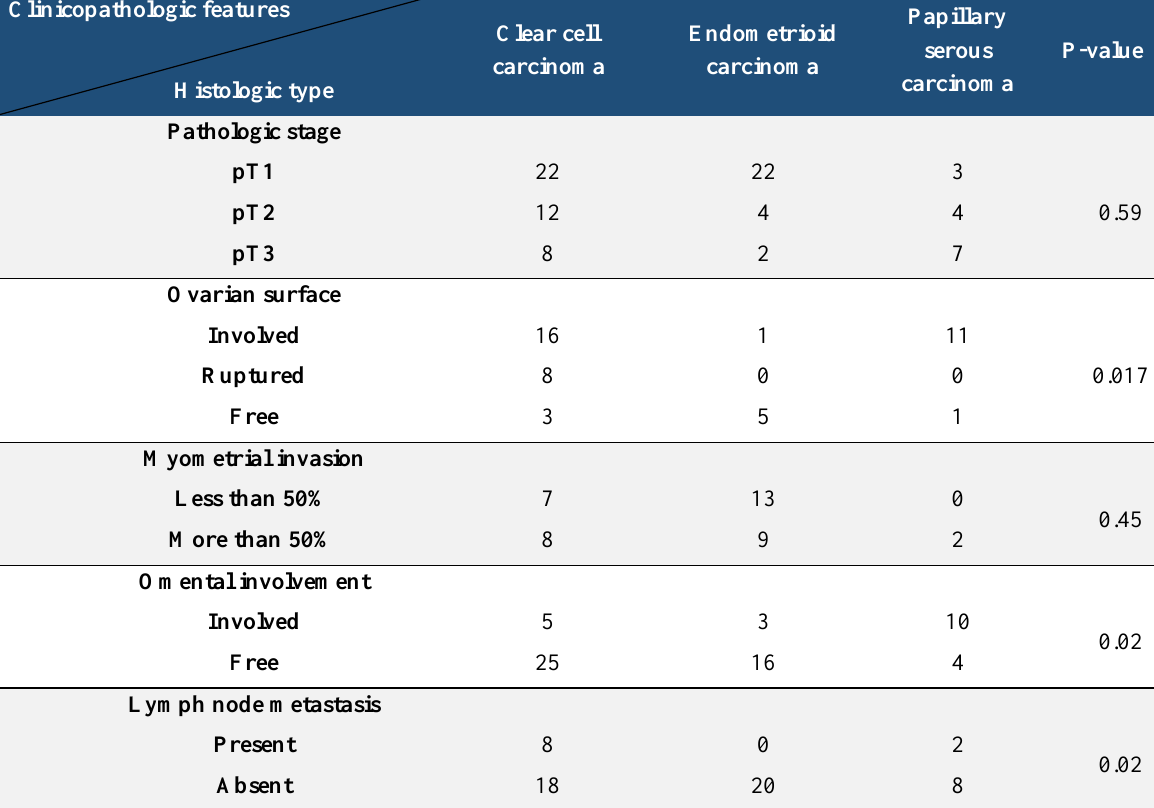
Table 1. Clinicopathological features of different ovarian and endometrial carcinoma subtypes in this study. Clinicopathologic features